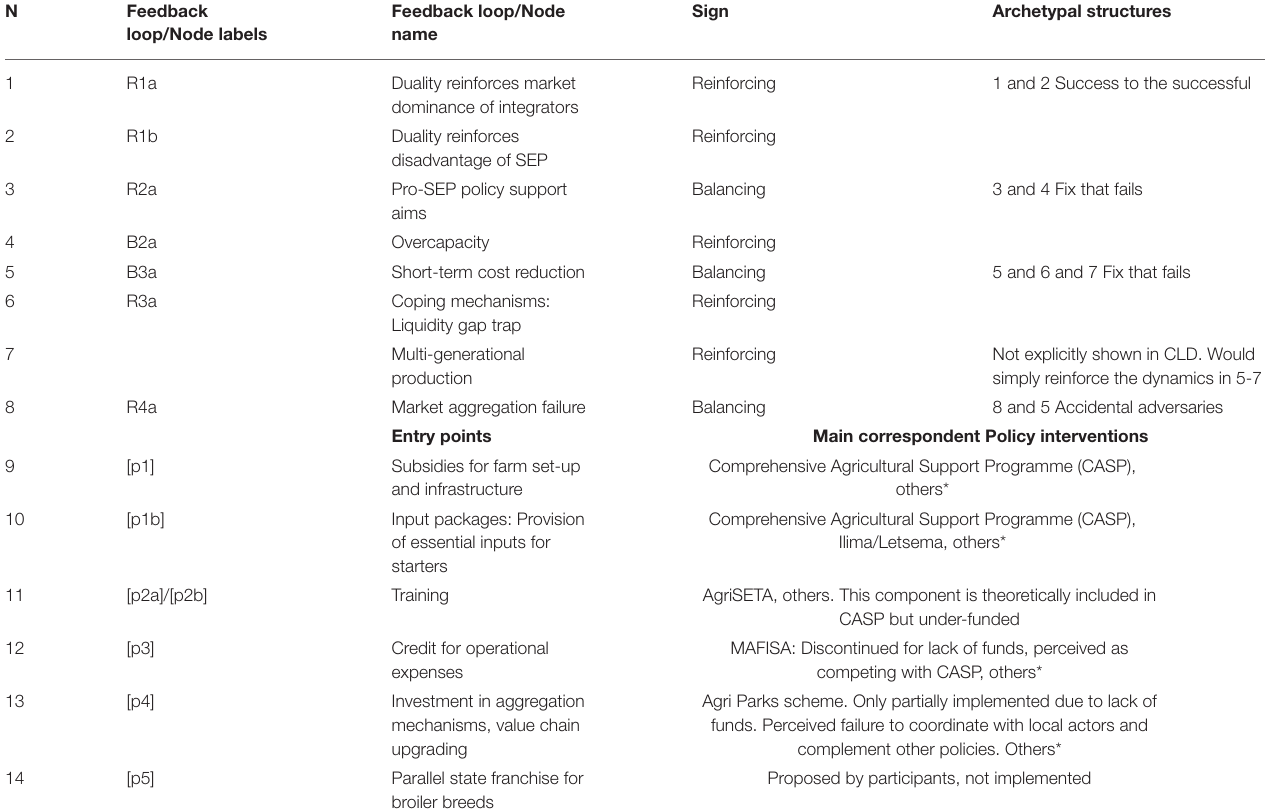
TABLE 2 | Causal loop diagram elements: feedback loop codes, descriptive naming, loop sign and correspondence to archetypal system dynamics